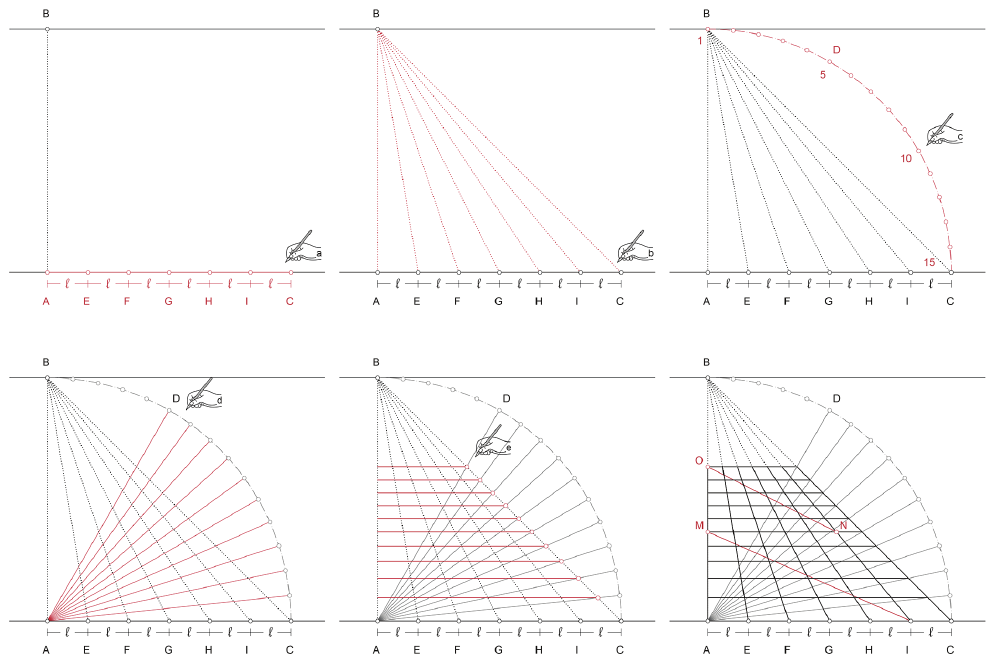
Figure 7 Illustration of the perspective construction with the first false rule described by Danti. Author’s